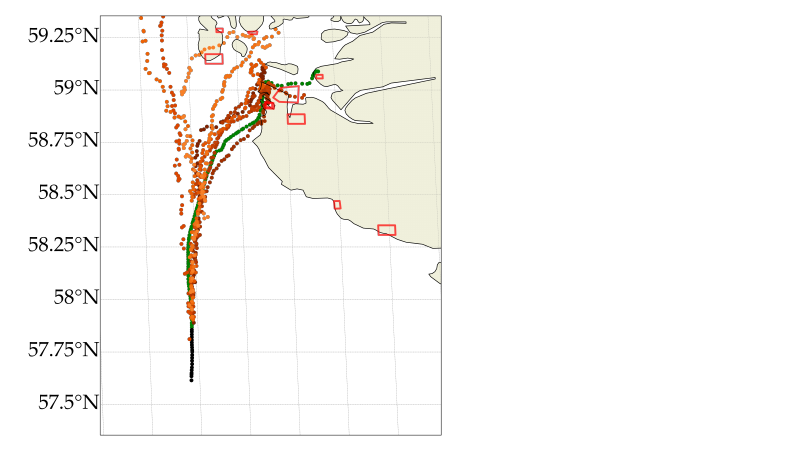
Figure 6. 10 predicted trajectories 36 times steps into the future (3 h) in a complex scenario. The model occasionally predicts the wrong trajectory and in rare cases, the future trajectory is predicted to go through, e.g., an island. Two trajectories are predicted to sail northward, the rest are predicted to sail to larger harbours than Tau.